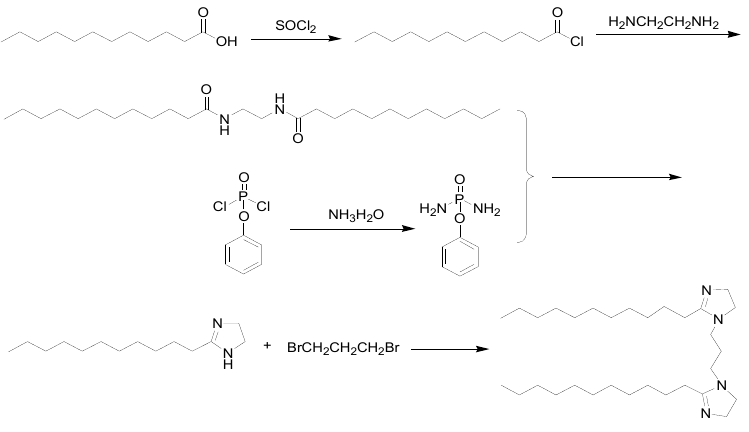
Figure 1. Route of new imidazoline inhibitor synthesis.